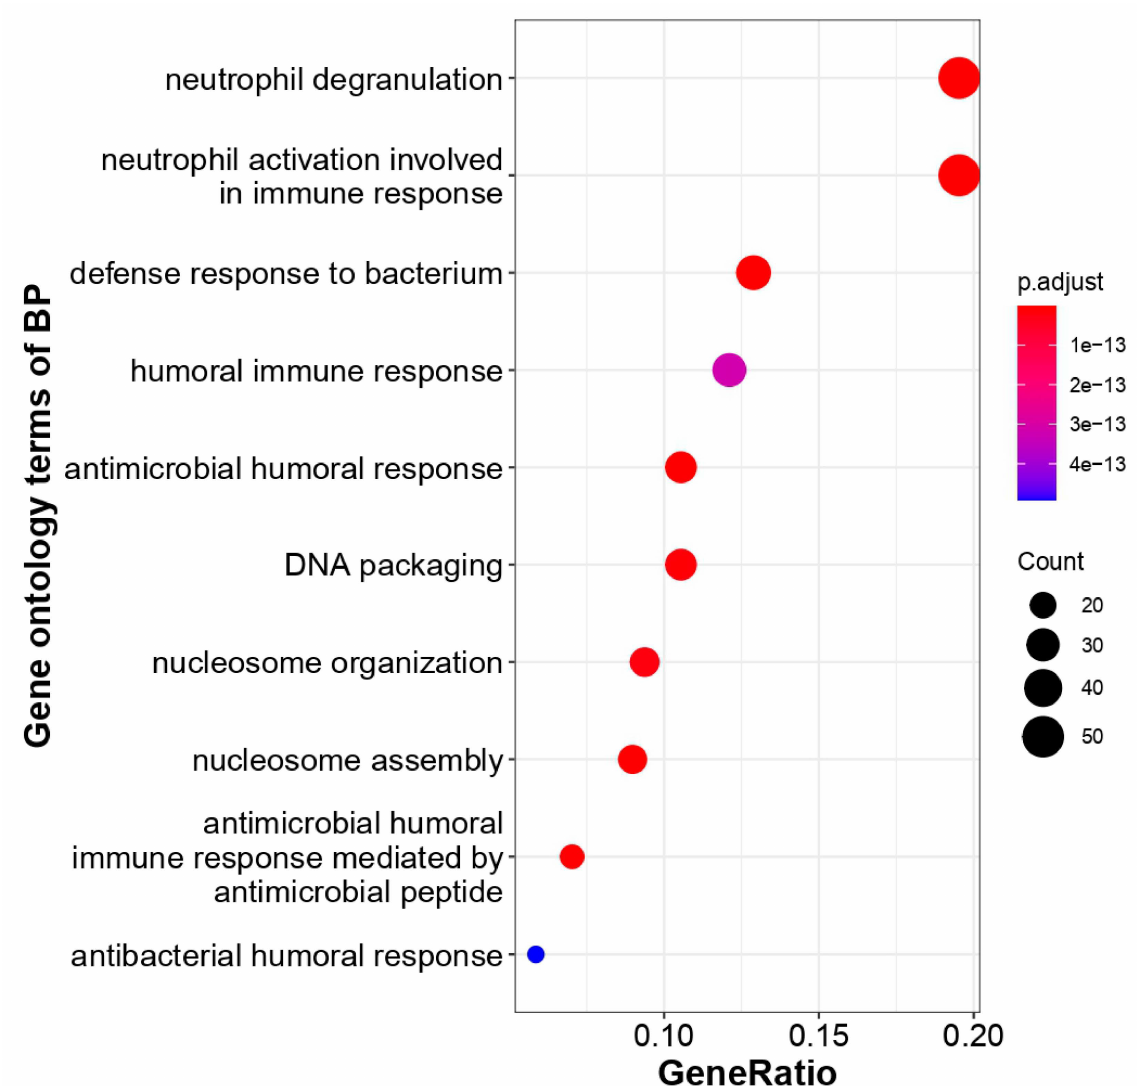
Figure 5. GO enrichments of COVID-19-associated unique genes with their biological processes. The number of unique COVID-19-associated genes falling in each GO biological process term is directly proportional to the count ball size. The balls are color-shaded according to the significant enrichment level (log2FC cutoff ≥ 1, p -value cutoff ≤ 0.05, dysregulation type—all, GO- p -value cutoff ≤ 0.1, GO- q -value cutoff ≤